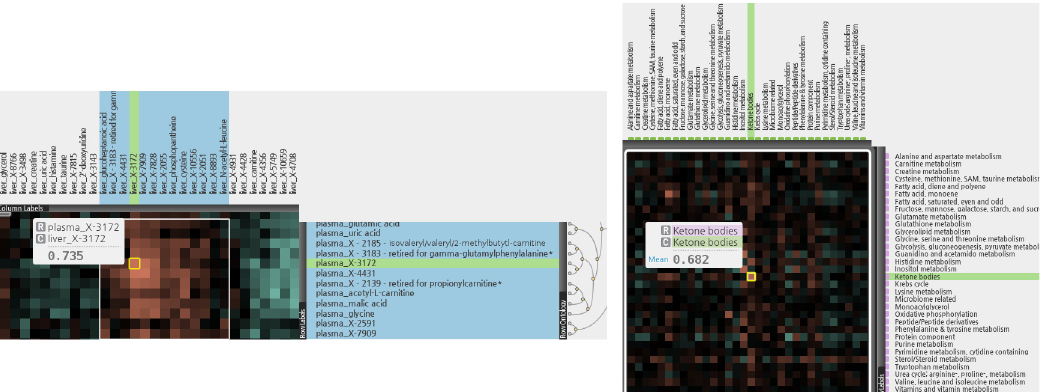
Fig 9. Coolmap and metabolic pathway correlations. Coolmap hierarchical clustering analysis was used for detection of relationships between liver and plasma metabolic processes. Left panel: blocks of highly correlated individual metabolites were identified — this included the same metabolite in liver and plasma (for exampleX-3172). Right panel: Liver and plasma metabolites were grouped into ontologies, and CoolMap was used to examine correlations between different or the same groups of metabolites in liver and plasma. For the same metabolites in liver and plasma there were correlations between liver and plasma ketone bodies, and liver and plasma fatty acid monoenes (see text).